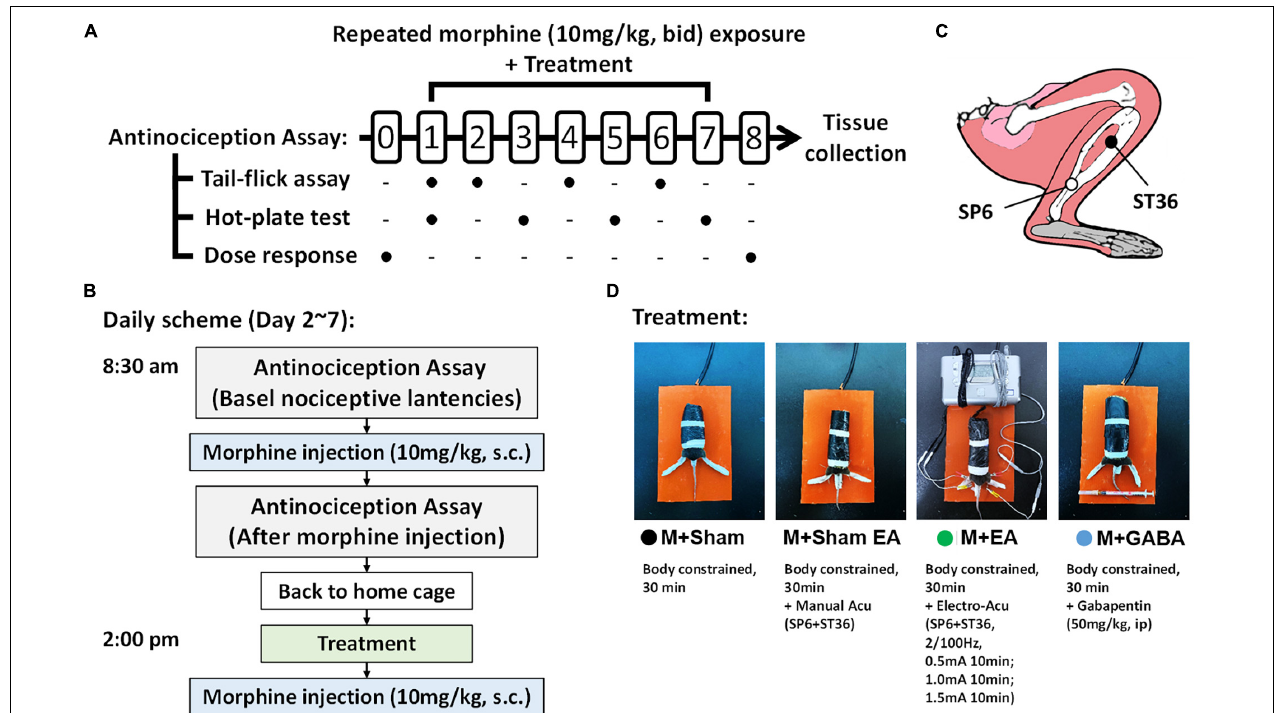
FIGURE 1 | Experimental method and flow chart. (A) Schematic illustrating the experimental design of the analgesia tolerance paradigm. Animals were acclimated to the testing environment and investigators for at least 2 weeks. Dose–response curves were determined using a cumulative dosing scheme on day 0 and day 8. The baseline latencies of both two assays were performed at day 1. From the 1st day to the 7th day, the tail-flick test and hot-plate test will be conducted alternately to compare the effects of different treatments on the development of morphine tolerance. (B) The Treatment and drug administration were performed as described above in the section “Materials and Methods”. (C) Schematic diagram of mouse acupuncture points of SP6 and ST36. (D) Different treatments between groups during the 2nd day to the 7th day.